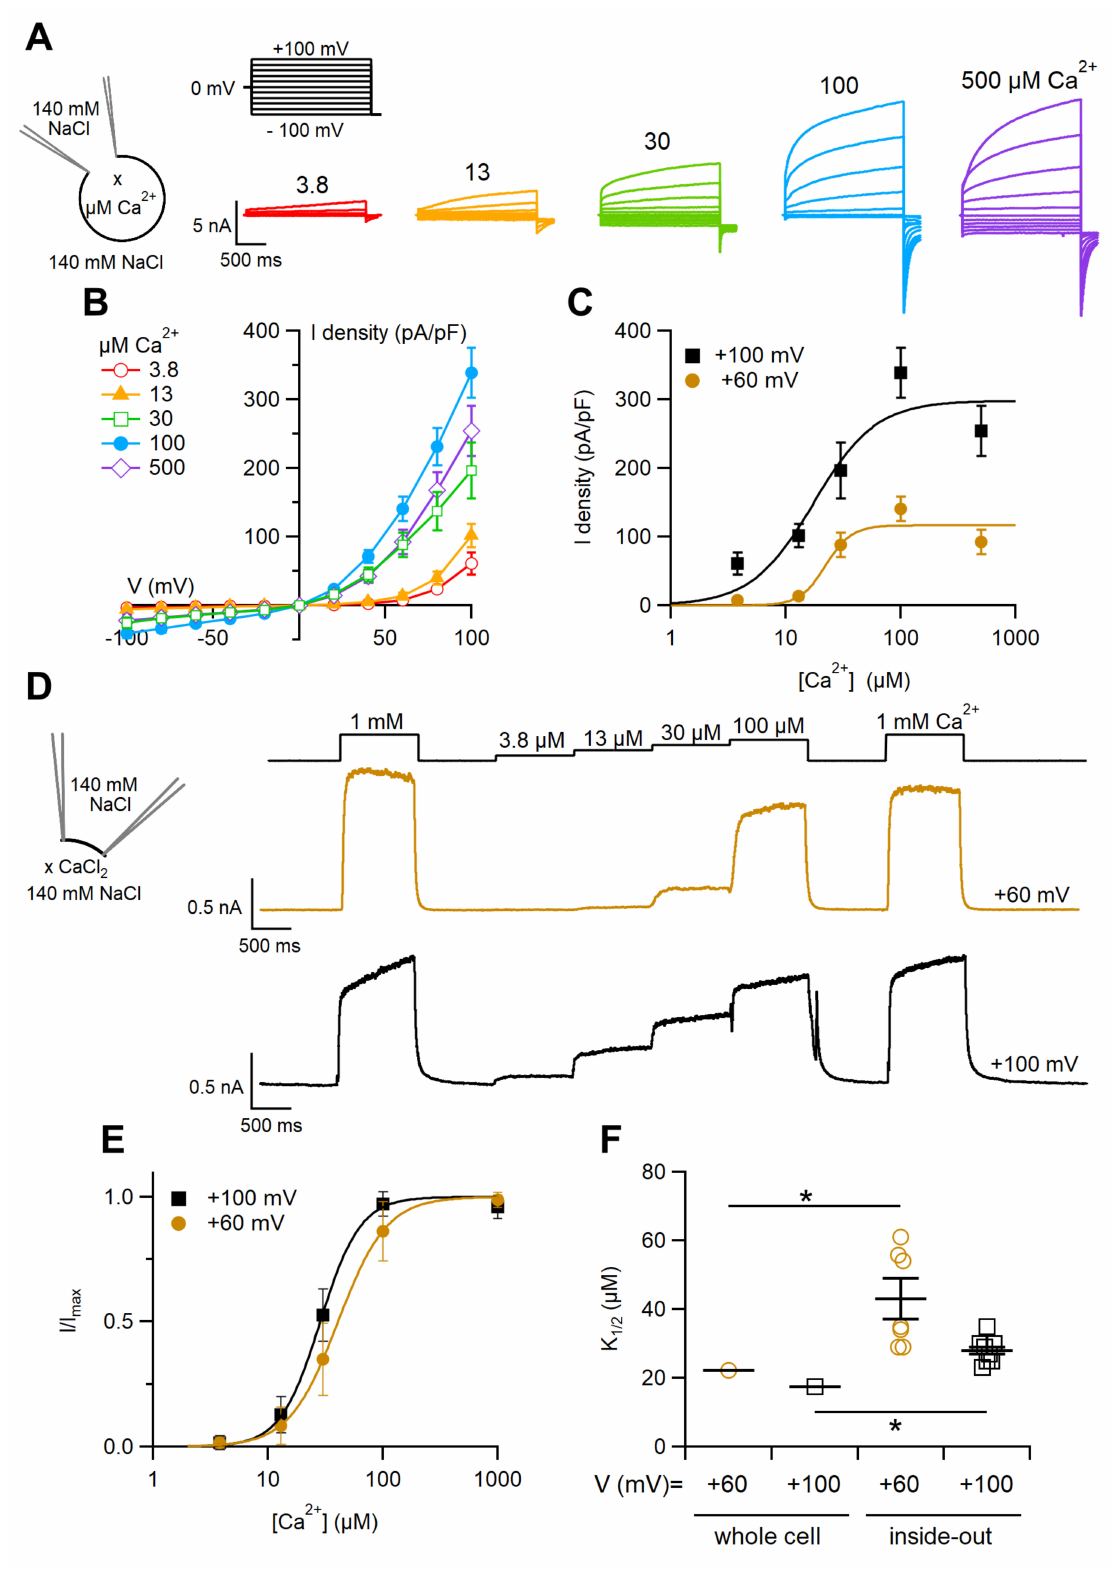
Figure 2. Ca 2+ sensitivity of the TMEM16F wt-mediated current. ( A ) Representative whole-cell currents recorded from TMEM16F wt-expressing cells with a pipette solution containing the indicated intracellular Ca 2+ concentrations (x).